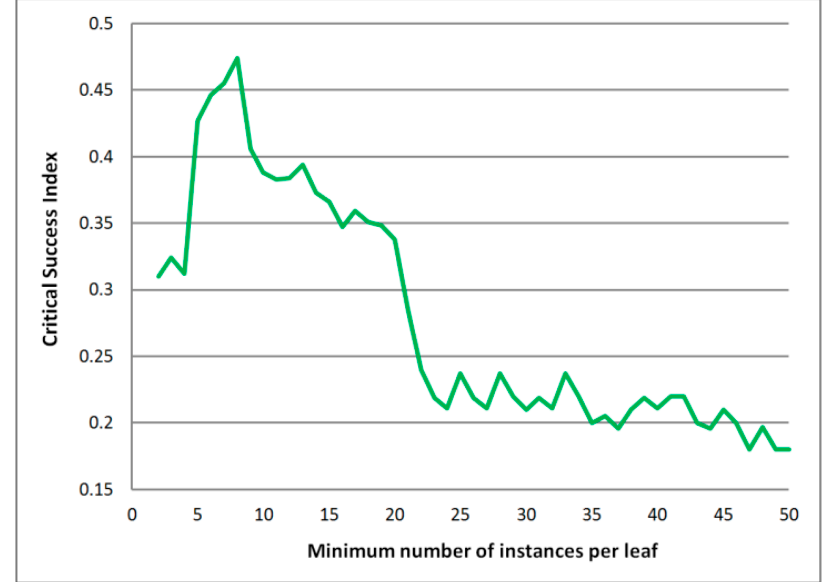
Figure 3. Critical success index (CSI) in function of the minimum number of instances per leaf.